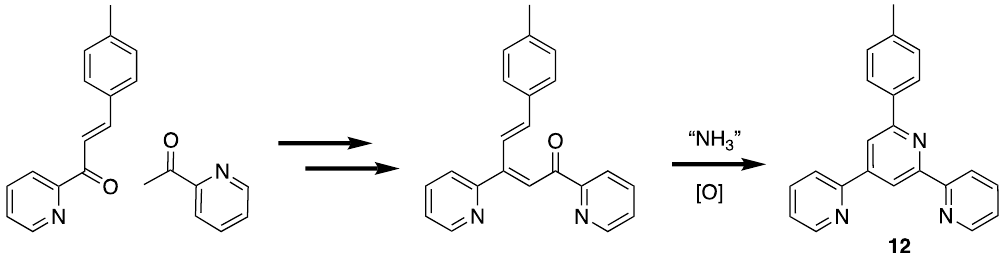
Figure 11. The structures of the 3:1 cyclohexane-1,3-diol derivatives arising from the condensation of the pentane-1,5-dione with Ar 1 COCH 3 .